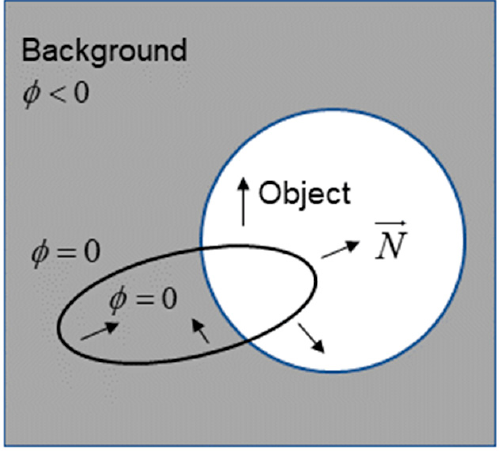
Figure 4. Representation chart of the LSM.